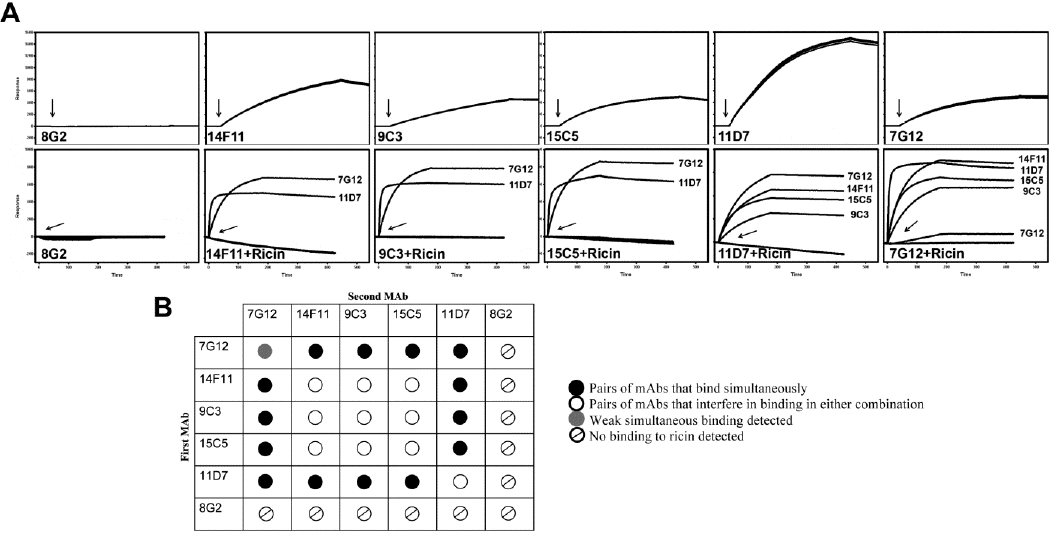
Figure 1. Summary of epitope-binning analysis of ricin mAbs using ProteOn XPR36 instrument. ( A ) Ricin solution (50 nM) was injected (injection points are indicated with arrows) over immobilized mAbs (upper panels). All six mAbs (100 nM) were then injected over mAb+ricin complex (lower panels, mAb injection points are indicated with arrows) and their binding to captured ricin was assessed; ( B ) The reactivity pattern matrix obtained in binning analysis. At least three distinct epitopes were observed. Monoclonal antibodies 7G12 and 11D7 bind two separate distinct epitopes whilst the third epitope is defined by mAbs 9C3, 14F11 and 15C5. 8G2 did not bind ricin in either